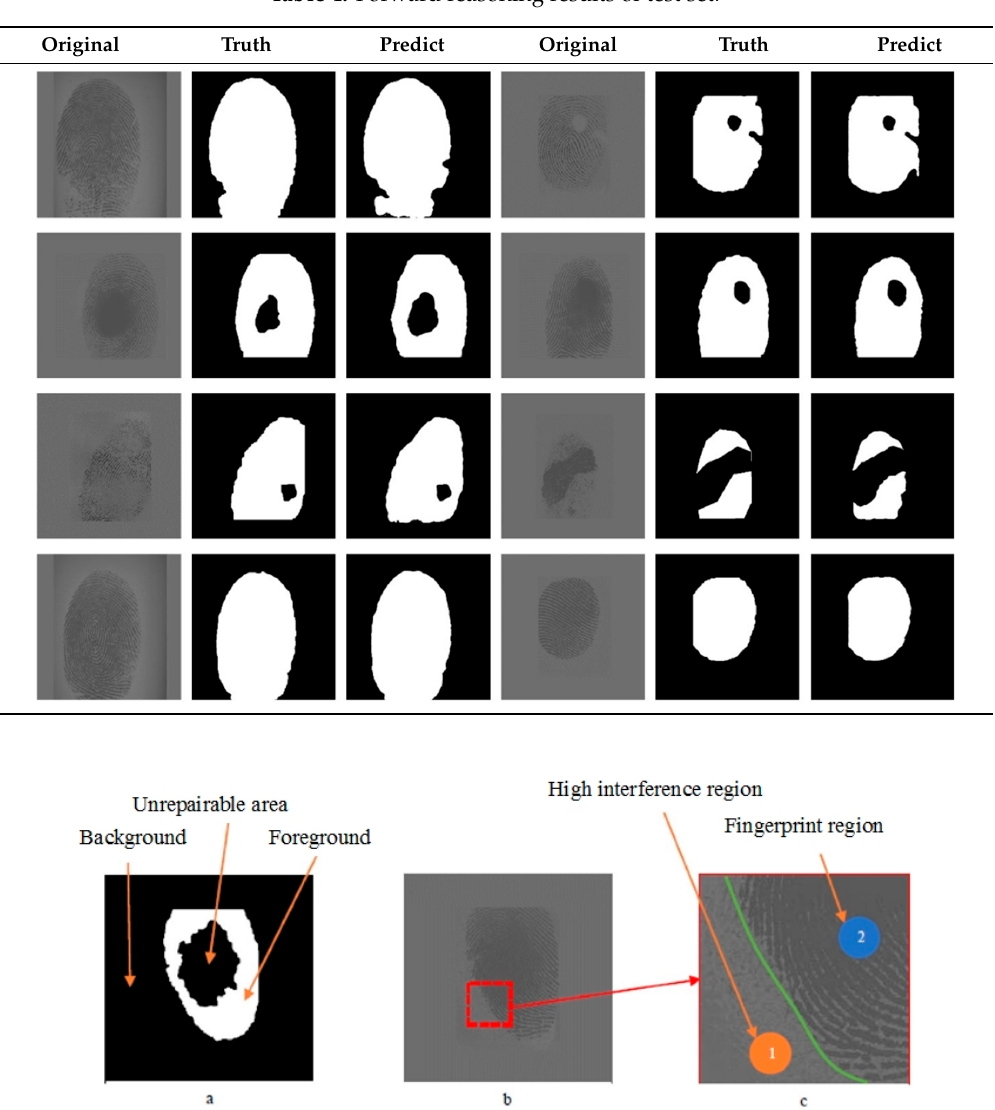
Figure 10. Fingerprint segmentation with high noise background. ( a ) The segmentation results of